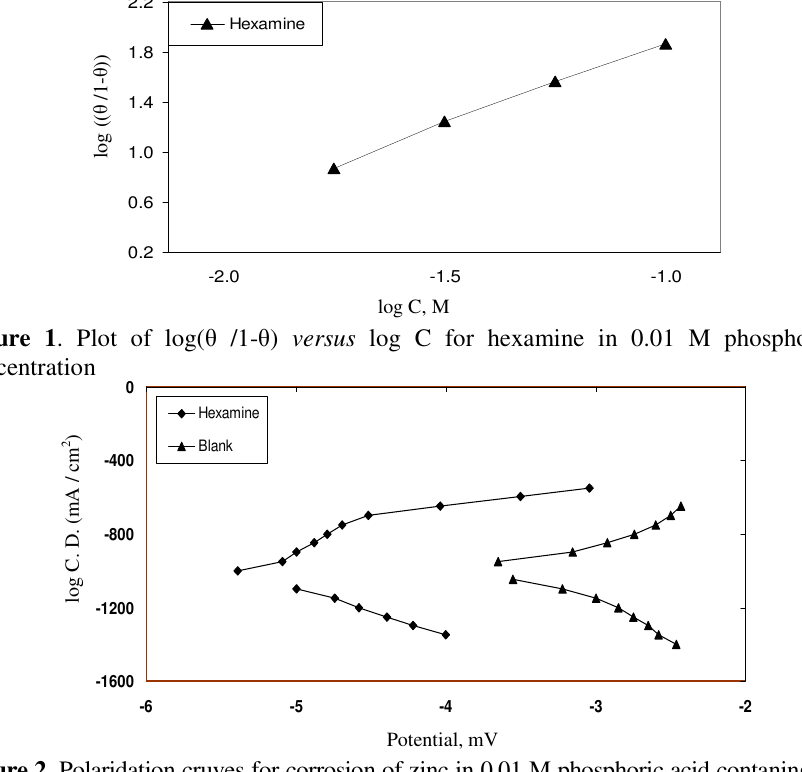
Figure 2. Polaridation cruves for corrosion of zinc in 0.01 M phosphoric acid contaning 80 mM